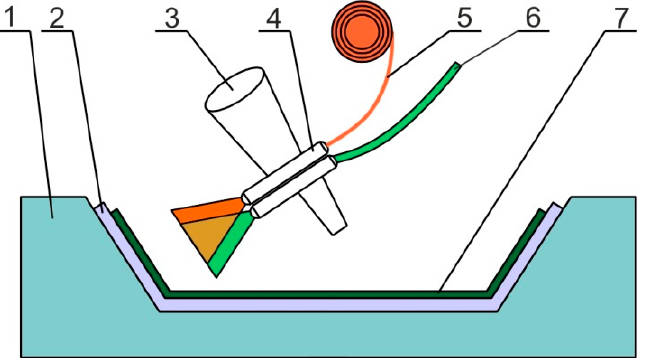
Figure 25. Scheme of spray lay ‐ up technique: 1—mould, 2—gel coat, 3—pot of resin catalyst pot, 4—chopper gun, 5—fibre, 6—air pressurised resin, 7—laminate. 4—chopper gun, 5—fibre, 6—air pressurised resin, 7—laminate.